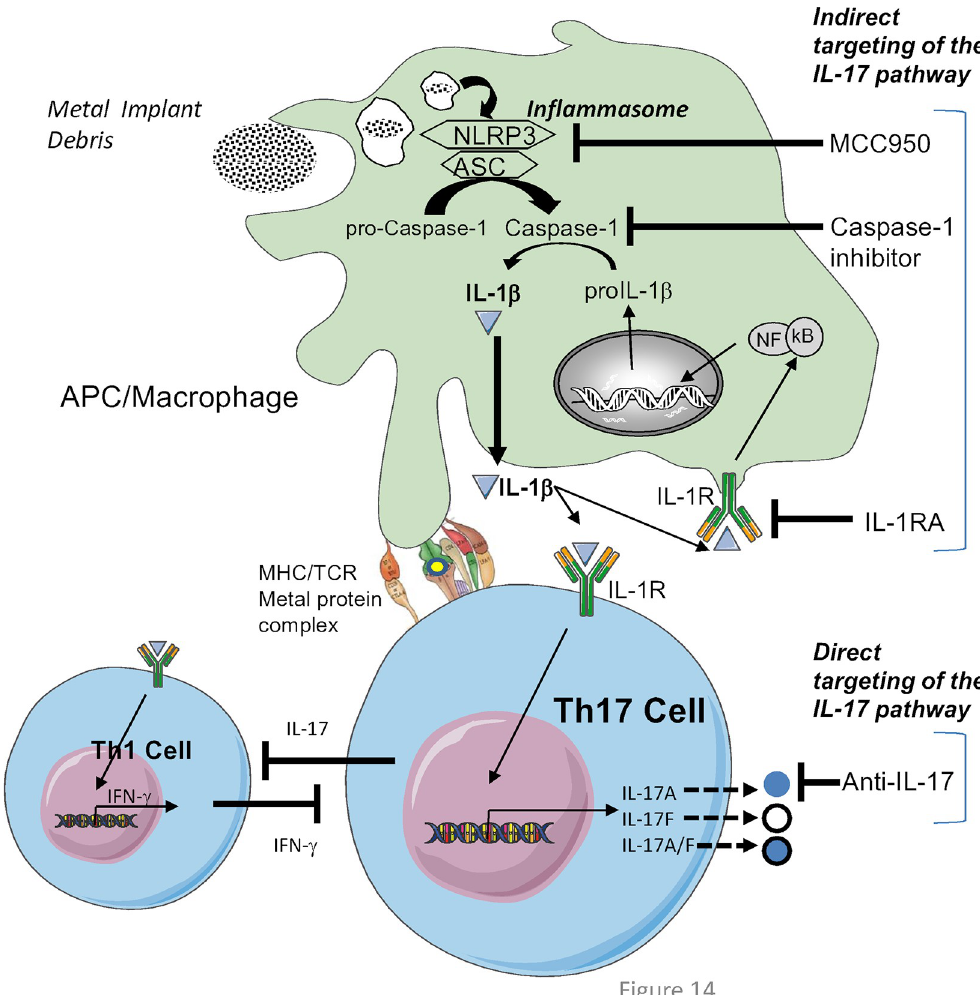
Fig 14. Graphical abstract depicting indirect and/or direct targeting of the IL-17 pathway to mitigate metal-DTH reactivity. A graphical representation of NLRP3 inflammasome activation in APCs by phagocytosis [64] of metal implant debris, which promotes IL-1 β signaling and the induction of a Th17-cell phenotype. And the possible biological targets that indirectly (via the inflammasome pathway) and directly (anti-IL-17A) target the IL-17 signaling pathway to decrease the severity of metal-DTH immune reactivity given our findings. IFN- γ is a signature cytokine of Th1 cells and is an important Th1 inducer, that can suppress Th17, Th2 and Treg cell differentiation [47]. While IL-1 and IL-17 are important for Th17 cell differentiation and can repress Th1 cell differentiation. Under metal-DTH responses, IL-1 and IL-17 are highly secreted, indicating more of a Th17 cells phenotype for metal-DTH immune reactivity.